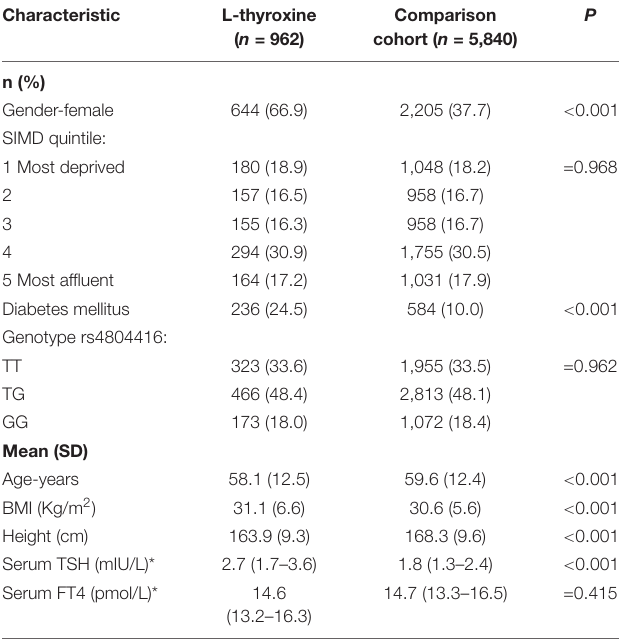
TABLE 1 | Description of patients on thyroid replacement therapy (L-thyroxine) and their comparison cohort at study entry ( n = 6,802). Characteristic L-thyroxine Comparison ( n = 962) cohort ( n = 5,840)